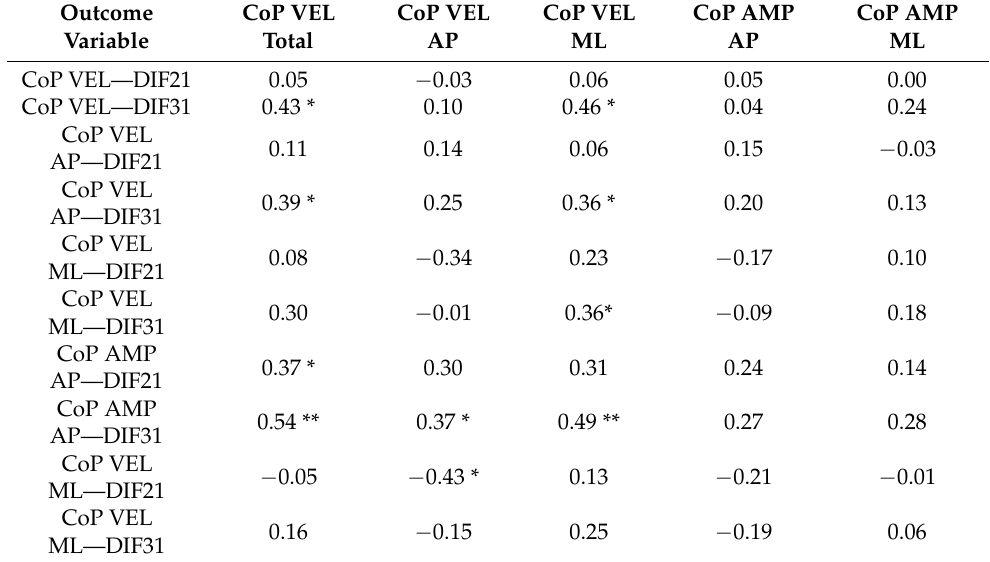
Table 1. The correlations between whole-trial variables and indices of transient behavior of body